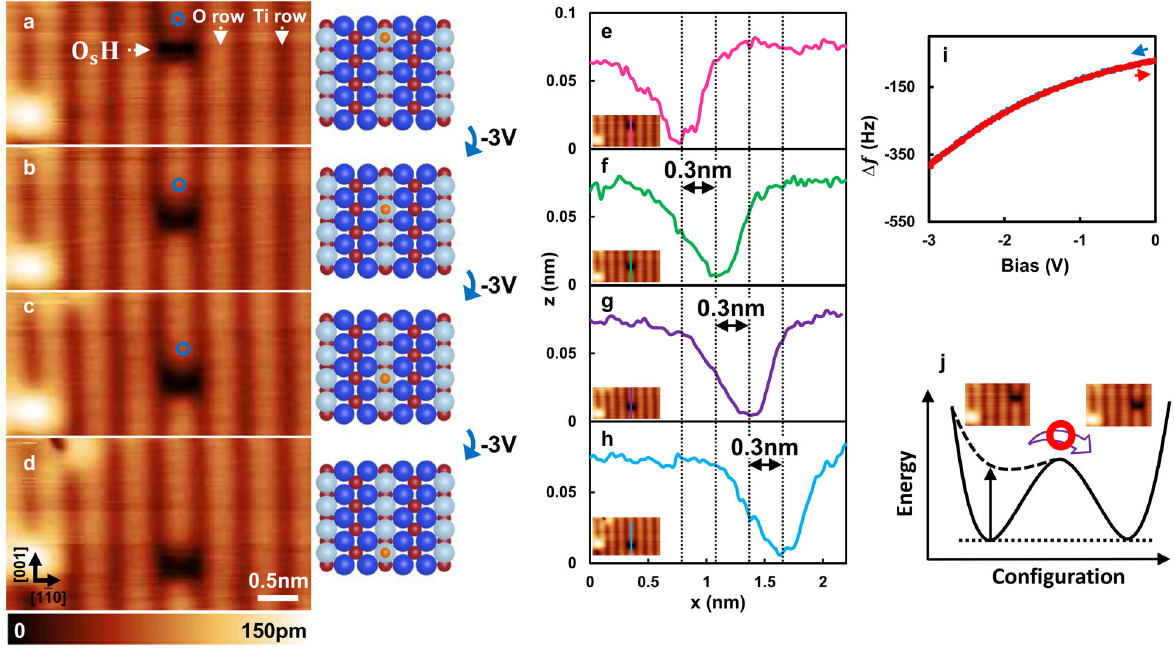
Fig. 6 Lateral manipulation of hydrogen atom along the [001] direction using the KPFS. a AFM image of O s H defect on the rutile TiO 2 surface. b – d Consecutive AFM images obtained after KPFS on top of the oxygen row. The tip position is indicated by a blue circle in the images ( a – c ). Imaging parameters for a – d : constant Δ f mode, V bias = 0 V, a – c 2.1 × 5.2 nm 2 , and d 2.8 × 5.2 nm 2 . e – h Line pro fi les measured for the O s H defect and substrate. The black dotted lines indicate the position of the hydrogen atoms. The positions of the line pro fi les are shown in different colors in the inset images. i Typical KPFS performed during the lateral manipulation shown in a – c . The feedback loop was switched off during the KPFS measurements, and the sample bias was ramped from 0 V to − 3 V and then back to 0 V. Naturally, no jump in frequency shift was observed during the voltage ramp. j Schematic potential energy curves depending on the lateral position of the OH defect and applying a negative bias between tip and sample. The black arrow indicates the perturbation of the